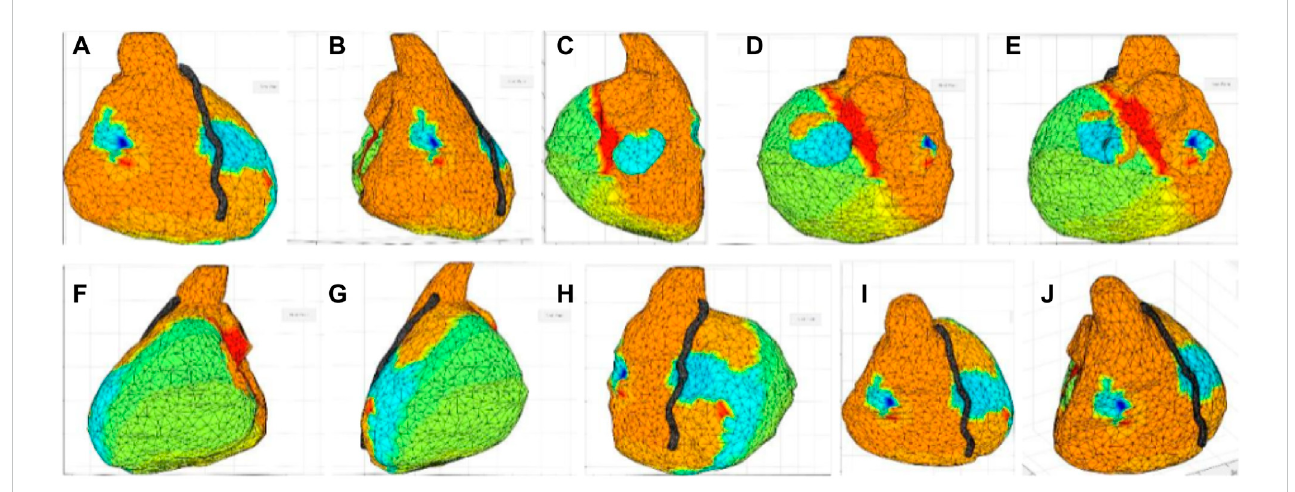
FIGURE 1 ImagecollectionfromtheUZCBIT software.Startingimagesforphotogrammetricreconstruction; (A) Image30 ° anglewithelevationangleonthex-axis of 0 ° , (B) Image 60 ° angle with elevation angle on the x-axis of 0 ° , (C) Image 120 ° angle with elevation angle on the x-axis of 0 ° , (D) Image 150 ° angle with elevation angle on the x-axis of 0 ° , (E) Image 210 ° angle with elevation angles on the x-axis of 0 ° , (F) Image 240 ° angle with elevation angle on the x-axis of 0 ° , (G) Image 300 ° angle with elevation angle on the x-axis of 0 ° , (H) Image 330 ° angle with elevation angle on the x-axis of 0 ° , (I) Image 30 ° angle with elevation angle on the x-axis of 30 ° , (J) Image 45 ° angle with elevation angle on the x-axis of 30 ° .